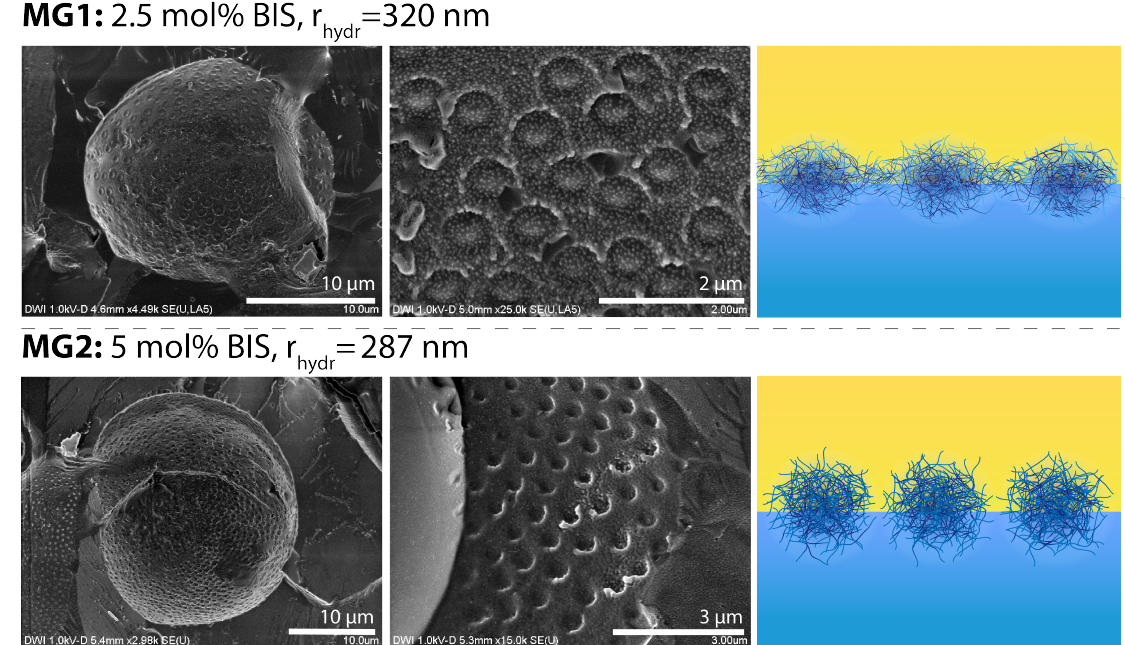
Figure 4. Cryo-SEM images of microgel-covered n -butyl acetate drops with different degree of cross-linking ( left side and middle ) and illustration of the microgel arrangement at the interface ( right side